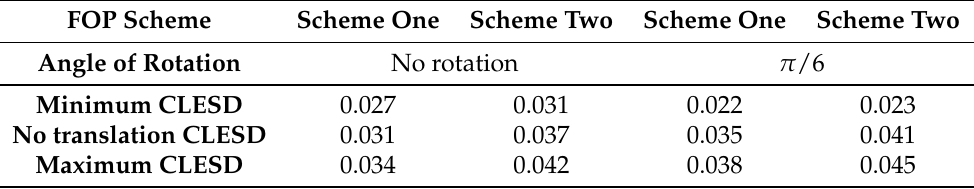
Figure 9. The FOP was translated for one period in the x (cid:48) and y (cid:48) directions. The FOP translation period in the x (cid:48) direction √ (cid:16) (cid:17) T y = 2 was ( T x = 2 R ) , and the FOP translation period in the y (cid:48) direction was 3 R . The connection between the FOP translation and the CLESD was established. ( a ) FOP scheme one: d f = 4 µ m; K = 0.7; angle of rotation: π /6. ( b ) FOP scheme two: d f = 6 µ m; K = 0.7; angle of rotation: π /6. Table 1. The impact of FOP translation on CLESD under different FOP schemes and rotation angles. No translation CLESD is the CLESD when FOP does not translate. Minimum CLESD is the highest CLA that the monocentric imager can reach due to FOP translation. Maximum CLESD is the lowest CLA that the monocentric imager can withstand due to FOP